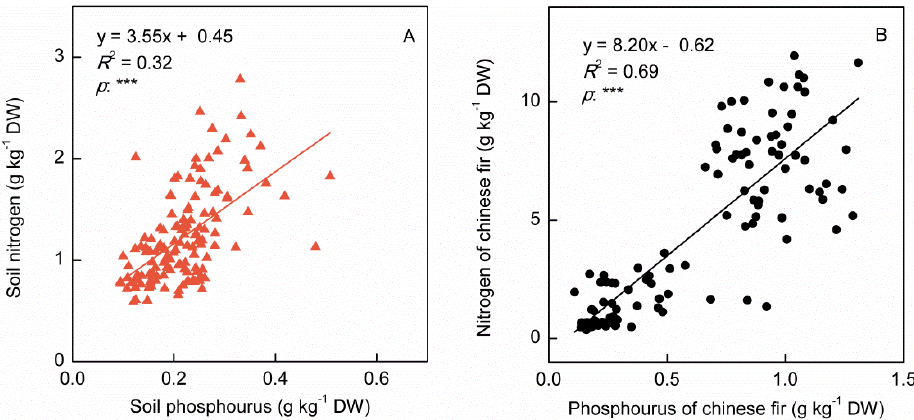
Figure 5. Correlation between nitrogen and phosphorus concentrations of all soil layers (( A ) n = 135) and all plant organs (( B ) n = 108), respectively. *** was indicated p < 0.001.